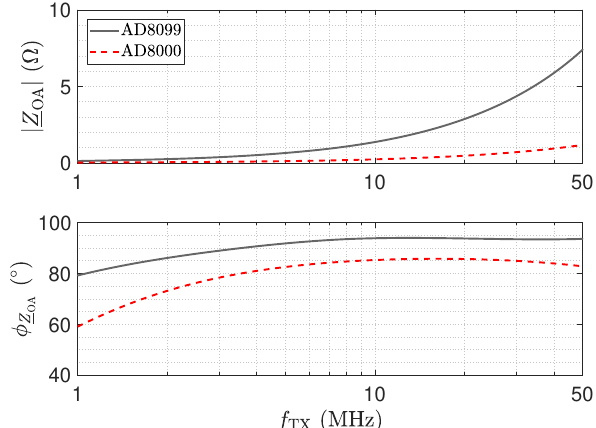
Figure 23. Input impedance magnitude | Z OA | and phase φ Z as depicted in Figure 21. The impedances have been determined by a SPICE simulation.